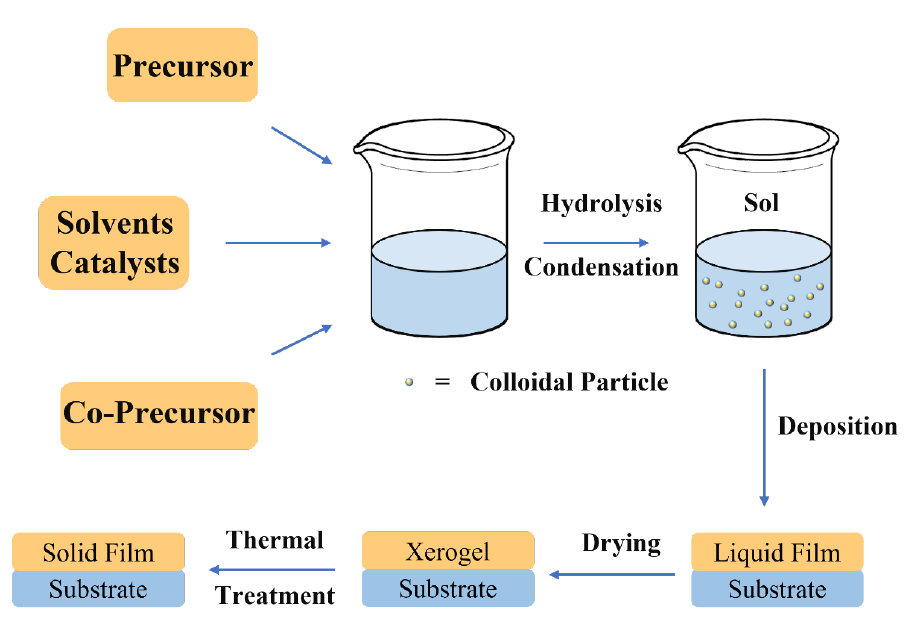
Figure 3. Diagram of the main steps in a sol – gel process.